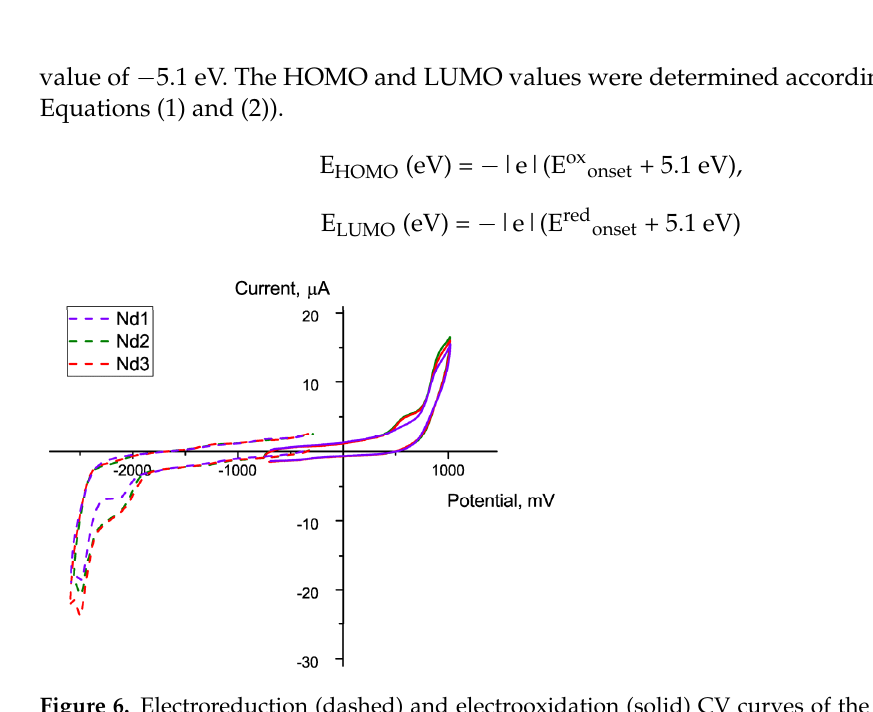
Figure 6. Electroreduction (dashed) and electrooxidation (solid) CV curves of the Nd1 , Nd2 and Nd3 complexes measured on glassy carbon working electrode in DMF (0.1 M Bu 4 NBF 4 ) solution at a potential sweep rate of 0.1 Vs − 1. Table 2. Electrochemical properties of the investigated Nd 3+ complexes in HCON(CH 3 ) 2